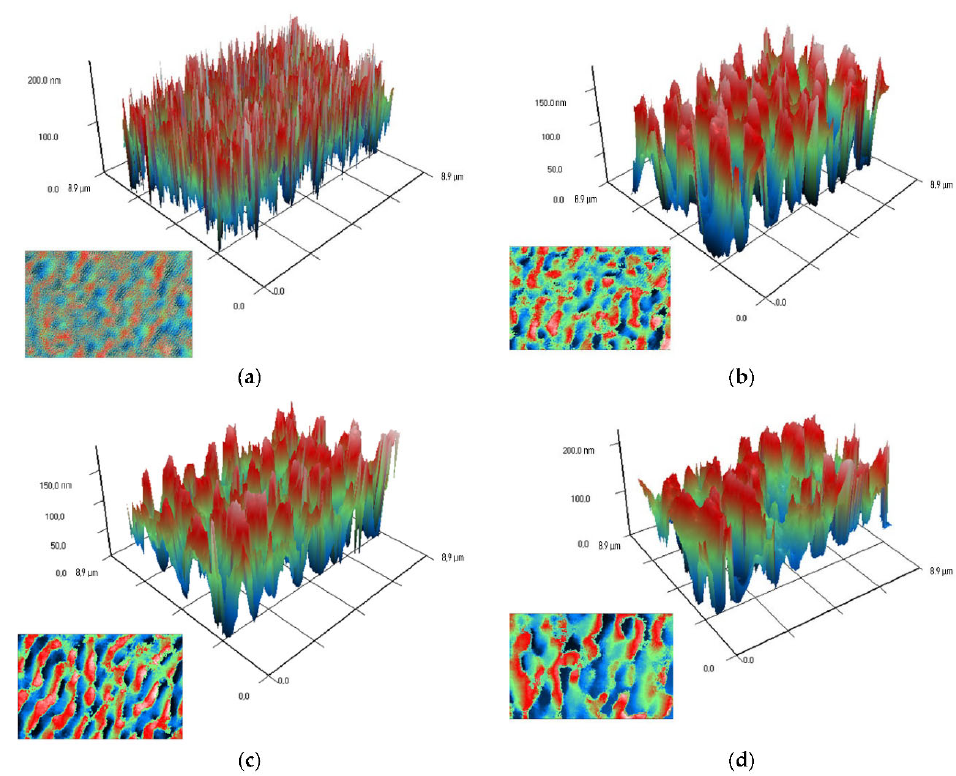
Figure 4. Modulation ‐ interference images of nanocomposites with different dopant content in the composition (pure PLGA ( a ), nanoparticles 0.001% ( b ), 0.01% ( c ) and 0.1% ( d )). X and Y ‐ axis frame size ( μ m); Z ‐ axis phase incursion (nm). The image in the lower left corner for each figure is a plan view projection showing the dopant distribution in the matrix.